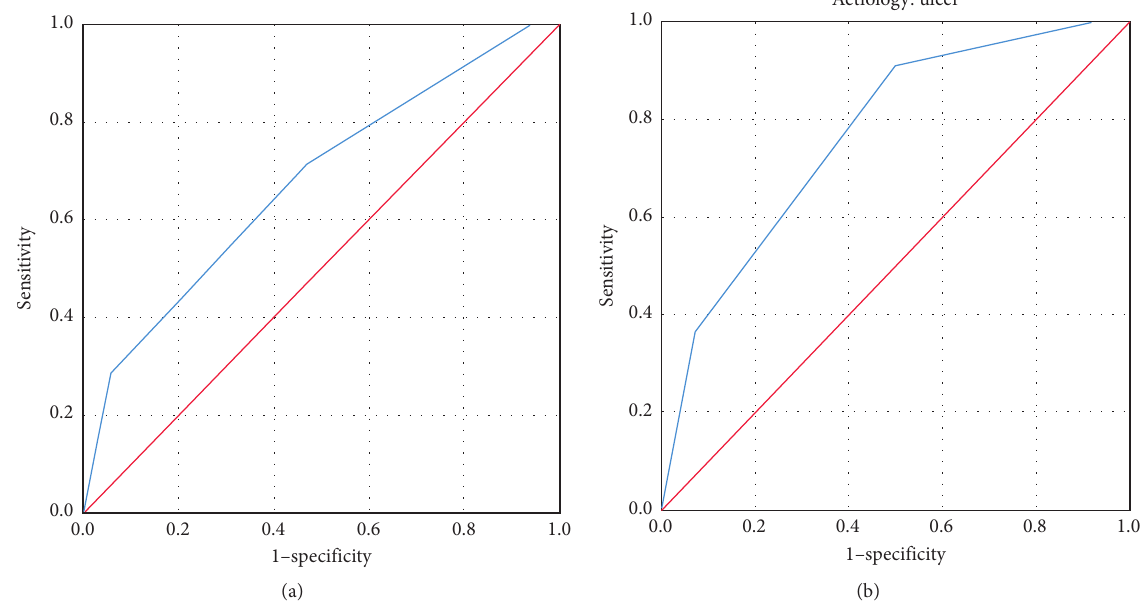
Figure 1: The area under the receiver-operating characteristic curve (AUC) for the (a) total group and (b) duodenal ulcer perforation